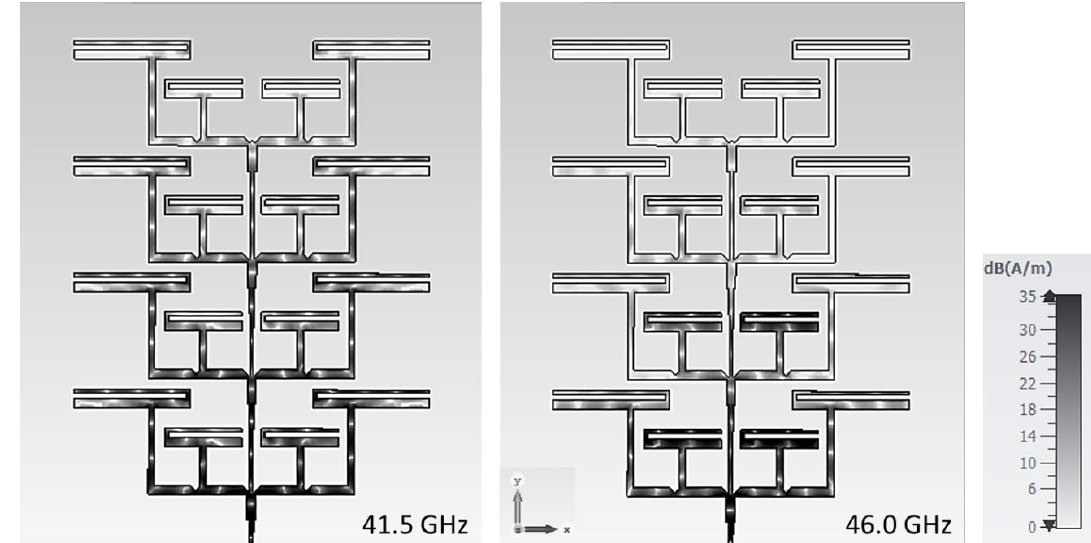
Figure 6. Surface current distribution of the proposed array antenna.